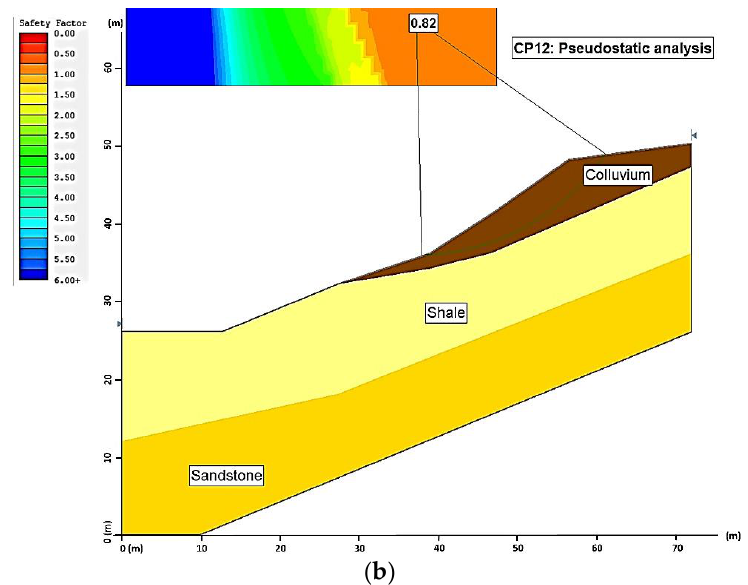
Figure 10. CP12 profile results in ( a ) static condition and ( b ) pseudostatic condition. Table 16. Geotechnical parameters used in stability analysis. Colluvium data from [33]. Material